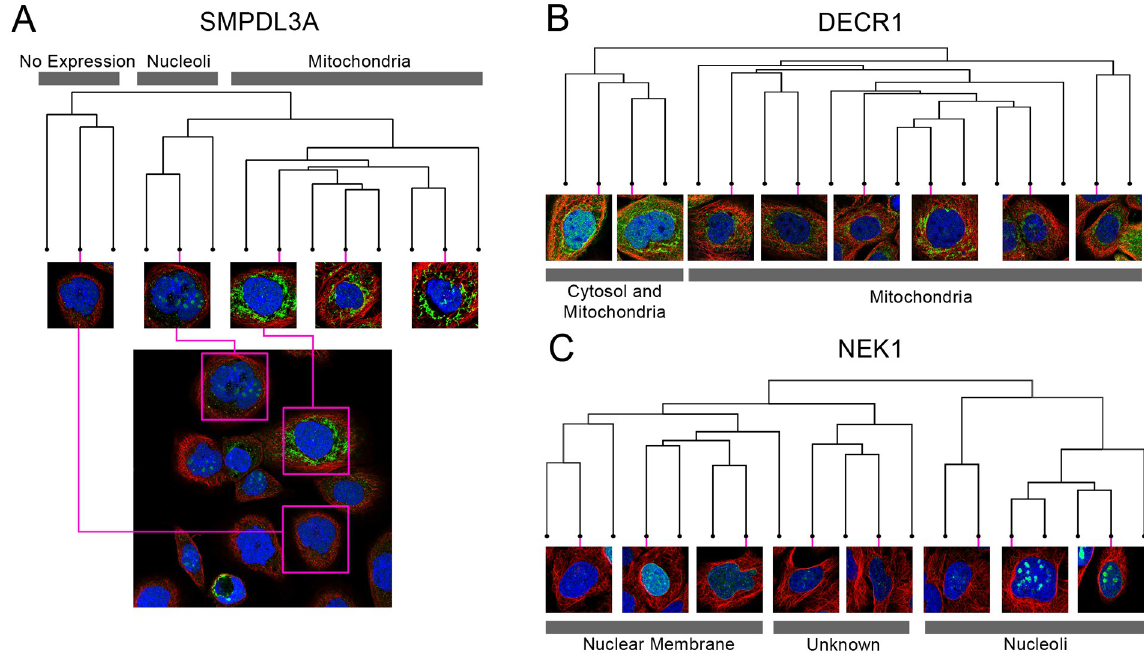
Fig 6. Dendograms from clustering the single-cell paired cell inpainting features of three spatially variable proteins: (A) SMPDL3A, (B) DECR1, (C) NEK1. For each dendogram, we show single-cell image crops associated with representative branches of the dendogram. For (A) SMPDL3A, we also show a field of view of the image, and where various single-cell crops originate from in the full image (pink boxes). We label clades in the dendogram (grey boxes) with the apparent localization of the single cells.